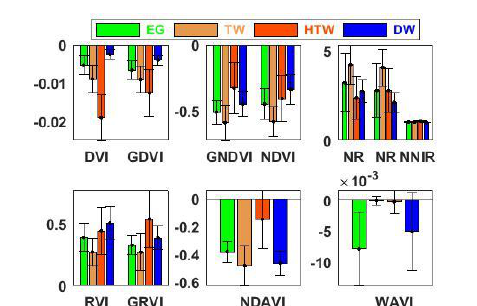
Figure 5. Mean values of the vegetation indices used in the study for each class for both images